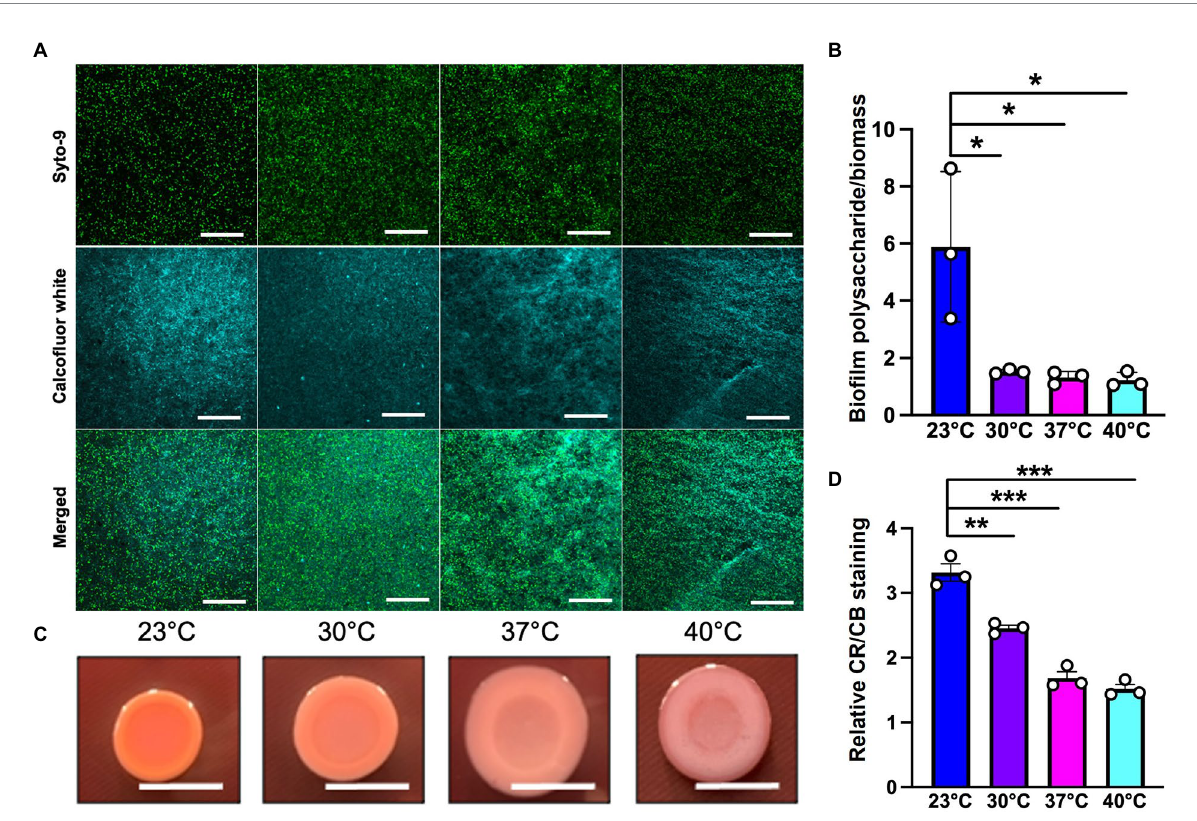
FIGURE 5 Microscopy using EPS-specific stains reveals temperature-induced increase in EPS carbohydrates in P. aeruginosa biofilms grown at 23 ° C. (A) The biofilm staining results of P. aeruginosa PA14 biofilm after 48 h of growth at 23 ° C, 30 ° C, 37 ° C and 40 ° C. Biofilm was grown for 48 h on a microscope glass slide at 23 ° C, 30 ° C, 37 ° C and 40 ° C and stained with SYTO 9 (live cells in green) and Calcofluor white (stains the polysaccharide component of the matrix cyan). Scale bar: 50 μ m. (B) Quantification of biofilm polysaccharide per biomass in P. aeruginosa PA14 biofilm after 48 h of growth at 23 ° C, 30 ° C, 37 ° C and 40 ° C using ImageJ. (C) Congo red binding assay reveals temperature specific difference in colony morphology. Extracellular matrix production by the wildtype was evaluated on tryptone agar plates containing Congo Red and Coomassie brilliant blue G after incubation at the four temperatures for 72 h. Representative images of the colony morphologies of PA14 are shown. Scale bar: 1 cm. (D) Quantification of CR and CB stain was performed using ImageJ. CR = Congo Red and CB = Coomassie Blue. Unpaired t-test (two-tailed) was used to measure statistical significance. * P ≤0.05 , ** P ≤0.01, and *** P